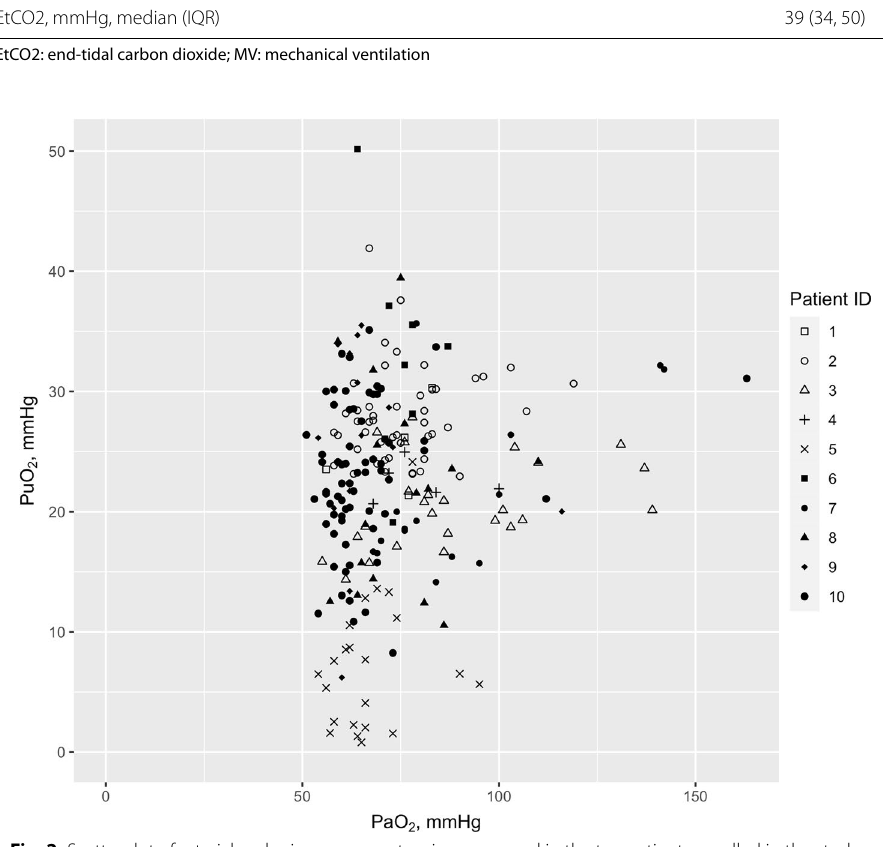
Fig. 2 Scatterplot of arterial and urinary oxygen tension measured in the ten patients enrolled in the study. PuO 2 : urinary oxygen tension; PaO 2 : arterial blood oxygen